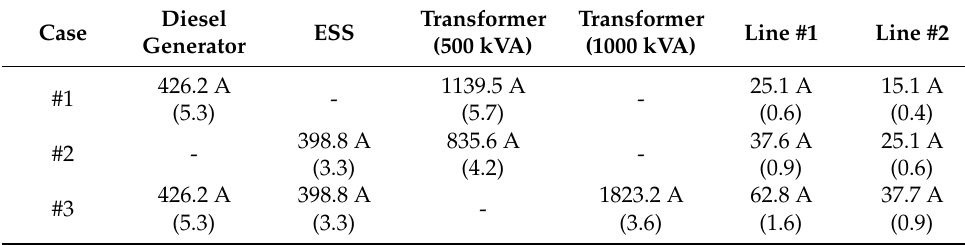
Table 6. Coordination results of Tap (pick-up current) for isolated